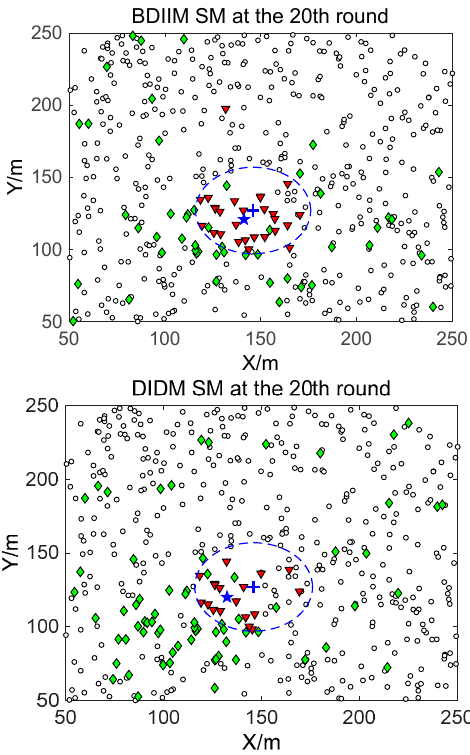
Figure 6. The state of the SM at the 20th time interval.